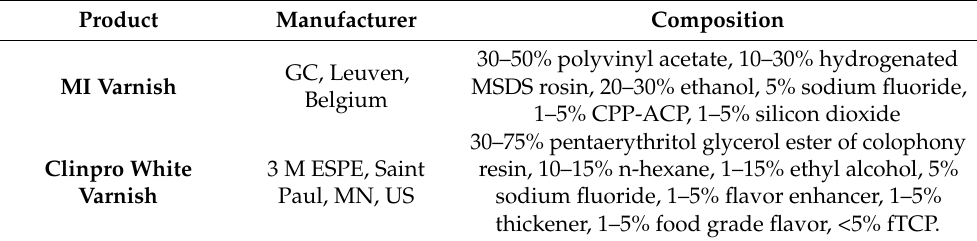
Table 1. Product composition according to material safety data